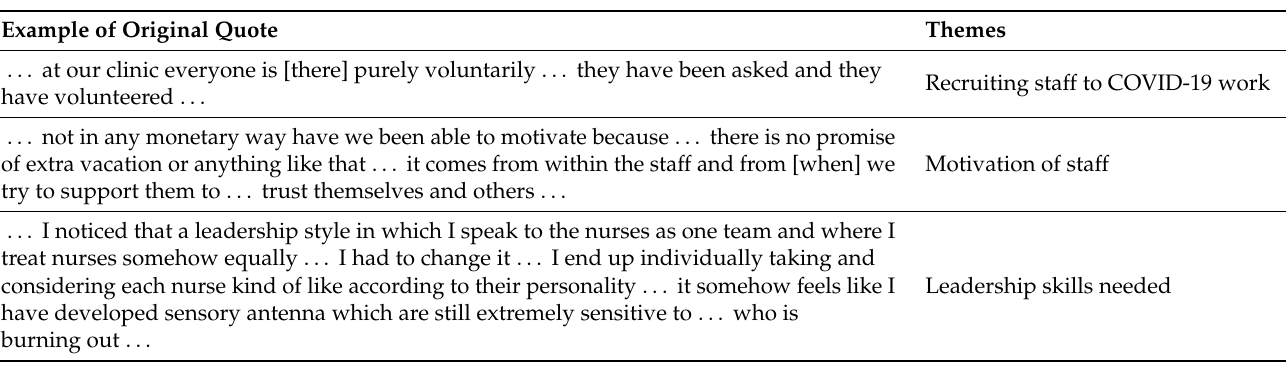
Table 4. Example quotes depicting motivation of